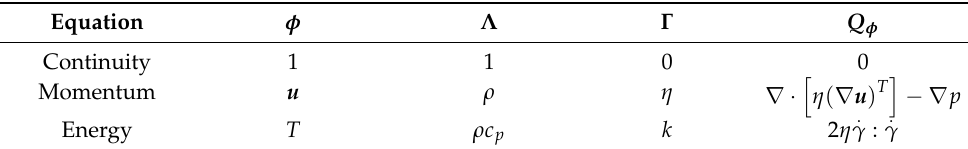
Table 2. Physical meanings of the symbols in the generalized transport equation.